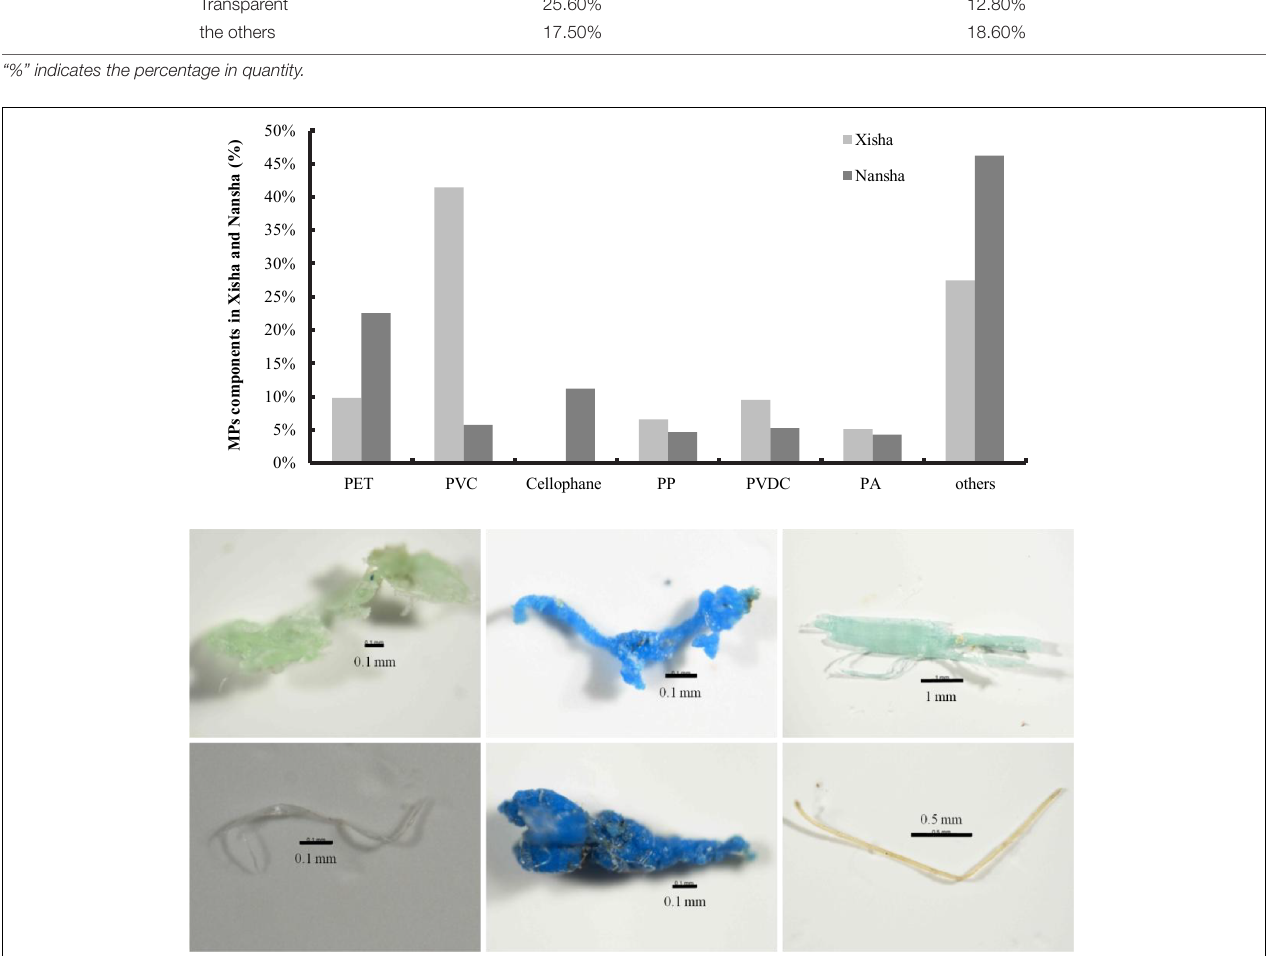
FIGURE 5 | The proportions of six prominent MPs polymers in surface water around Xisha Islands and Nansha Islands. The figures below show each representative MPs particle of the six main polymers, the first row from left to right is polyethylene terephthalate (PET), polyvinyl chloride (PVC), and cellophane; the second row from left to right is polypropylene (PP), PVDC, and polyamide (PA). These MPs particles had a µ -FTIR spectral match of 85% or more.